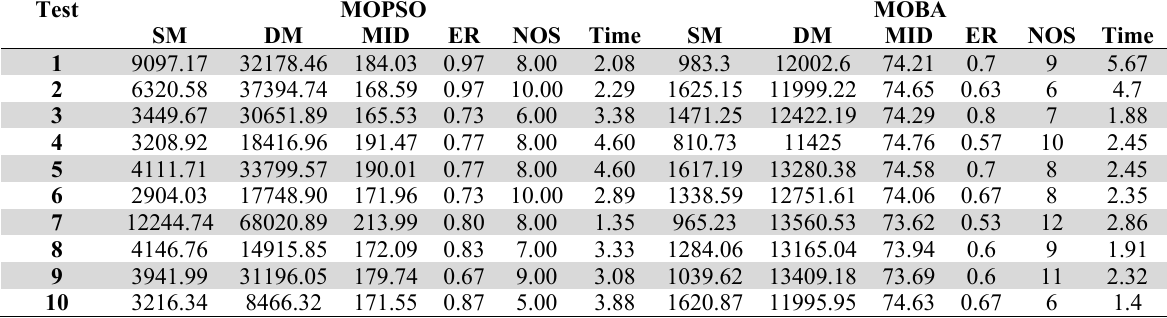
Fig. 7. Scatterplot of the performance of MOPSO & MOBA (raw material inventory model) Experimental results of six metrics in raw material inventory